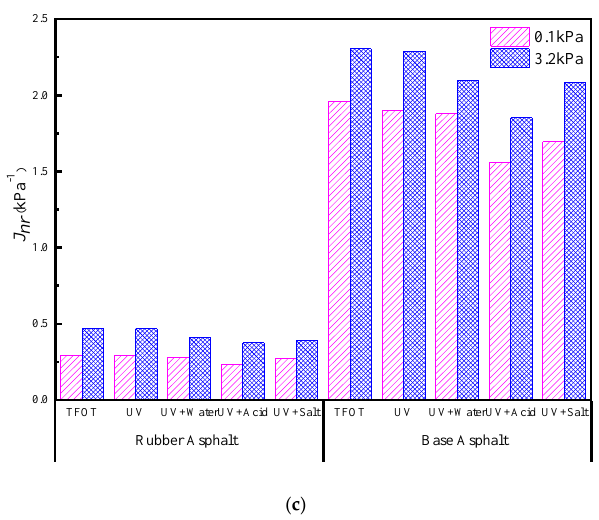
Figure 2. ( a ) Asphalt rutting factor after UV aging under different environmental conditions. Note: BA is base asphalt and RA is rubber asphalt; ( b ) R after UV aging under different environmental conditions (60 °C); ( c ) J nr after UV aging under different environmental conditions (60 °C).